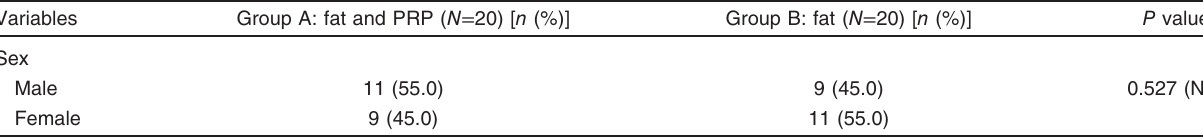
Table 2 Demographic characteristics in both